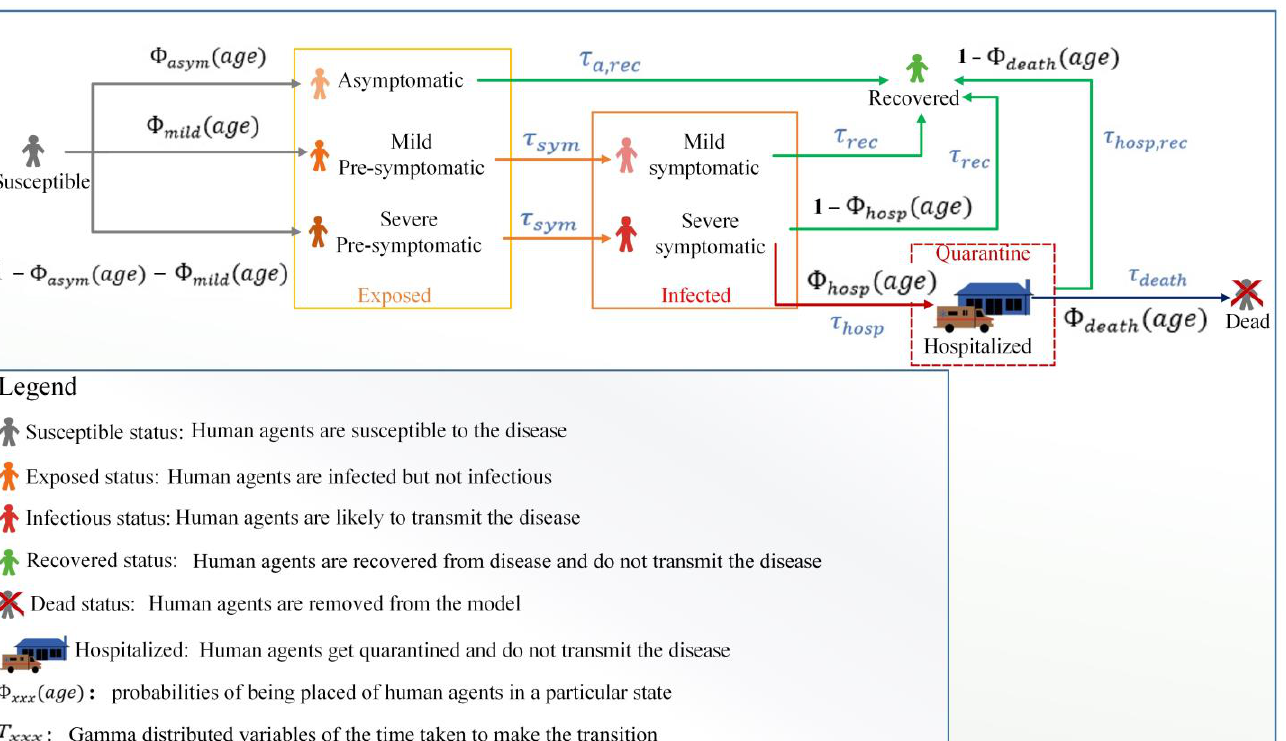
and (3) the interaction level between source and recipient agents. (3) the interaction level between source and recipient